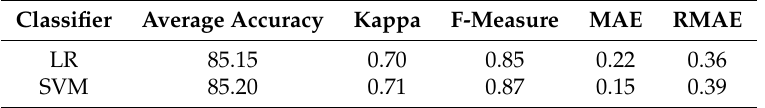
Table 6. Evaluation parameters for the best performing classifiers with α a as a